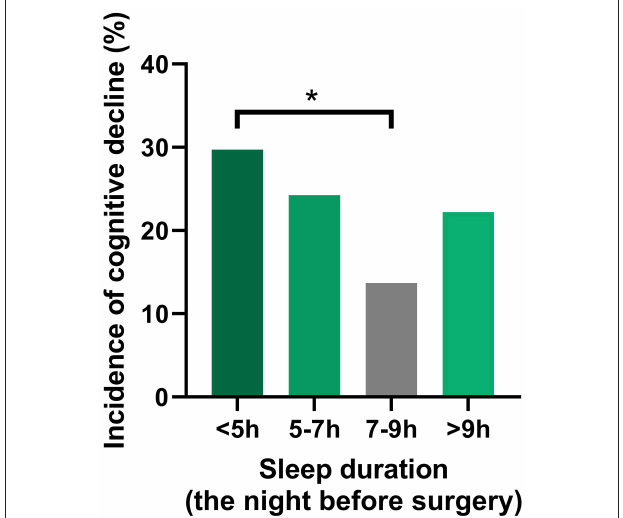
FIGURE 2 | Association between sleep duration and the incidence of POCD. A U-shaped association was found between sleep duration on the night before surgery and incidence of POCD. The group with a sleep duration of 7–9h exhibited the lowest incidence of POCD at 6 months after surgery. The logistic regression analysis demonstrated that the incidence of POCD was significantly elevated for the patients with a sleep duration < 5h, compared with